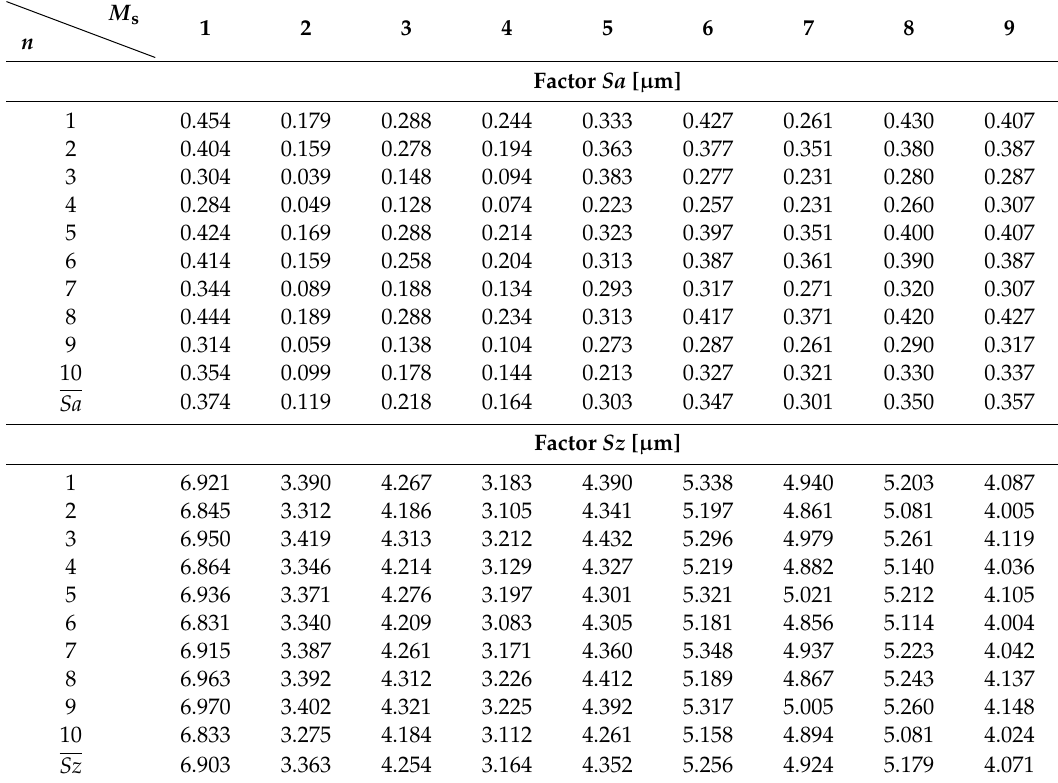
Table 2. Measurement series M s of the factors and Sa and Sz